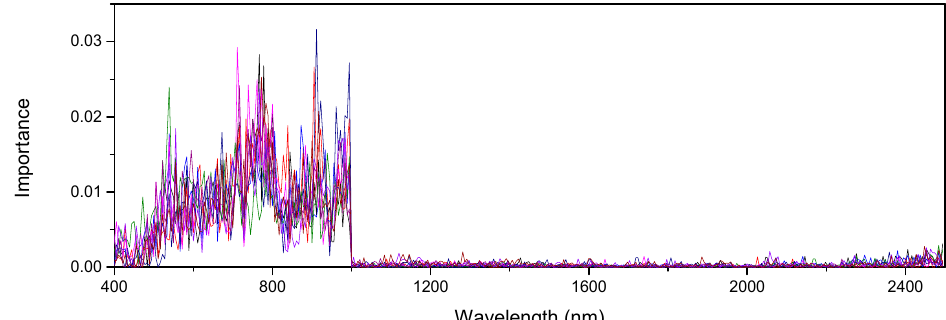
Figure 6. The importance of spectral band under food or medicine classification scale provided by random forest. The colorful curves have ten colors in total from experiments repeated 10 times.